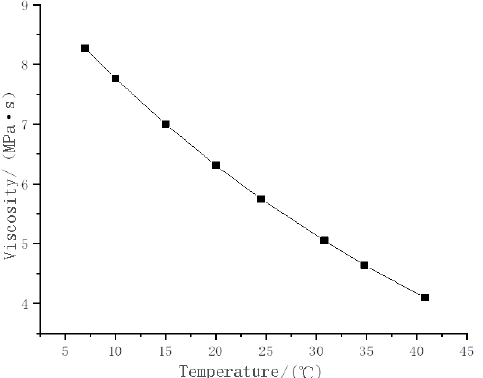
Figure 2. Viscosity–temperature curve of Shunbei crude oil. The heat flow–temperature curve of Shunbei crude oil was measured by DSC thermal analysis method, and the wax crystal solubility coefficient curve of Shunbei crude oil was obtained according to Li et al. [16], as shown in Figure 3. Analyzing the graph, it is found that the wax content of Shunbei crude oil is 4.46%, the cloud point is 17.31 ◦ C, and the peak of wax deposition is between 9.31 and 13.31 ◦ C.